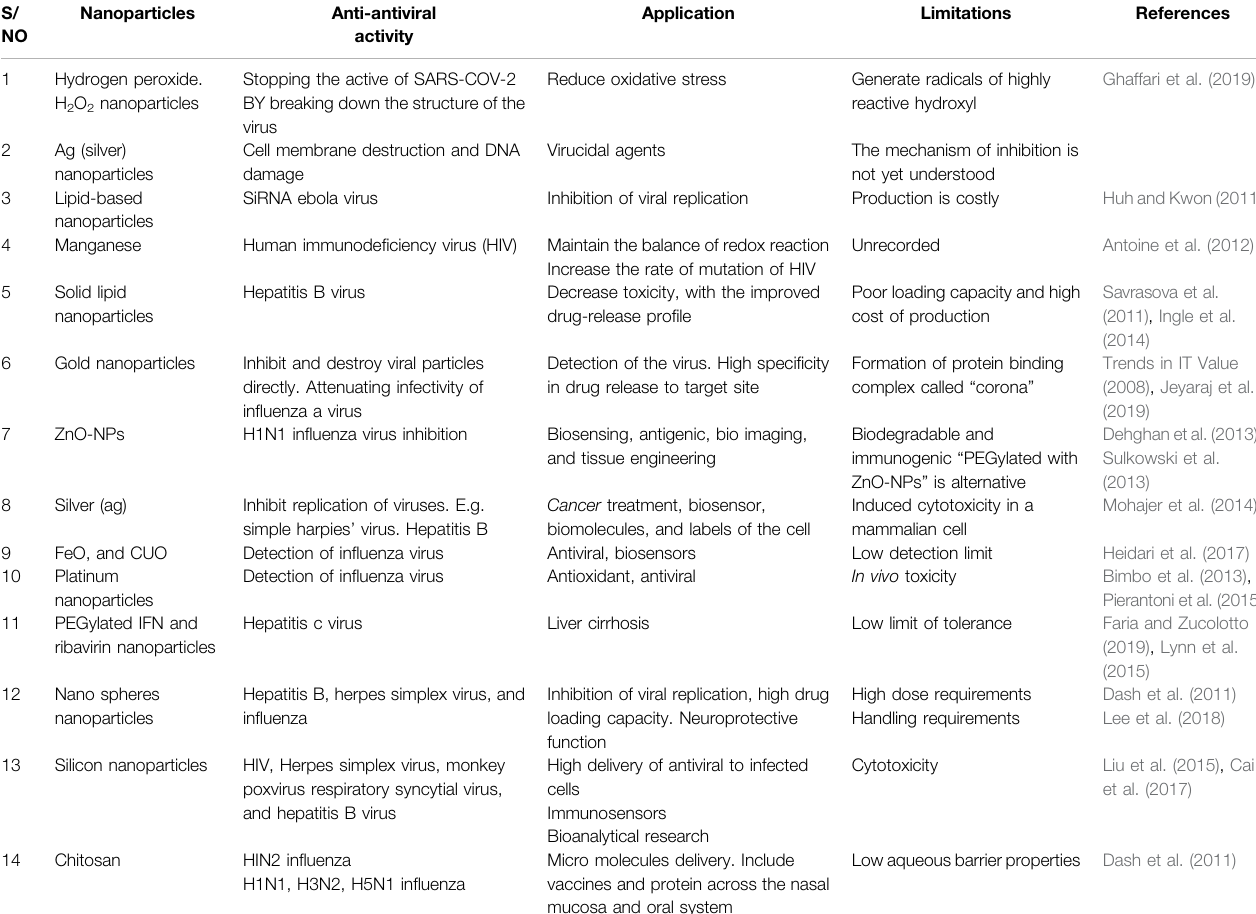
TABLE 5 | Antiviral nanomaterials, applications, and